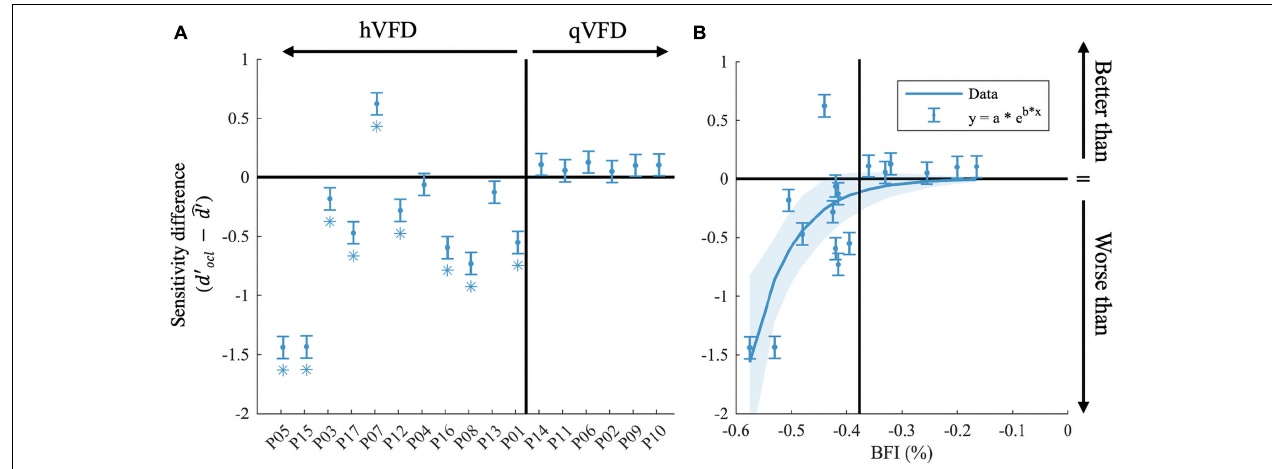
(cid:48) ) comparing the observed sensitivity of the OCL participants with that of the estimated FIGURE 5 | Effects of occipital lesions. (A) The sensitivity difference ( d (cid:48) O CL − b d sensitivity of the GIST model, sorted by the Blind Field Index from the largest (P05) to the smallest (P10). (B) Sensitivity difference as a function of BFI. In both plots, the black horizontal line indicates when the observed sensitivity is not different from the predicted sensitivity loss by occlusion; the vertical black line separates the hVFD and the qVFD participants. Error bars show the CI 95% and ∗ p -values < 0.05 after false discovery rate (FDR)